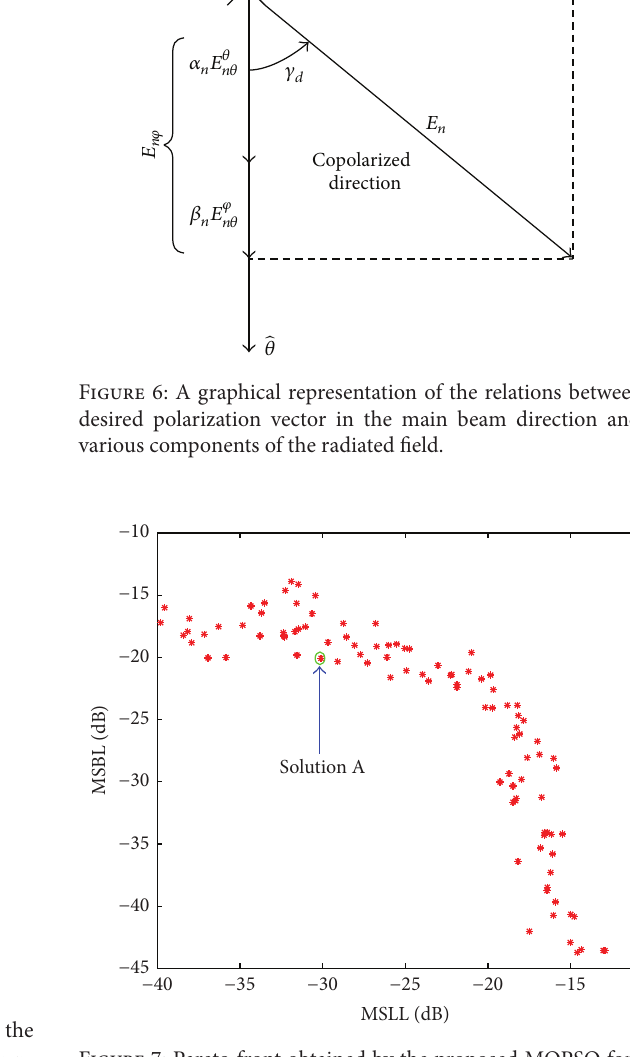
̂ 𝜃 Figure 7: Pareto front obtained by the proposed MOPSO for scan -direction and the 𝜑 - direction of (74 ∘ , 0 ∘ )